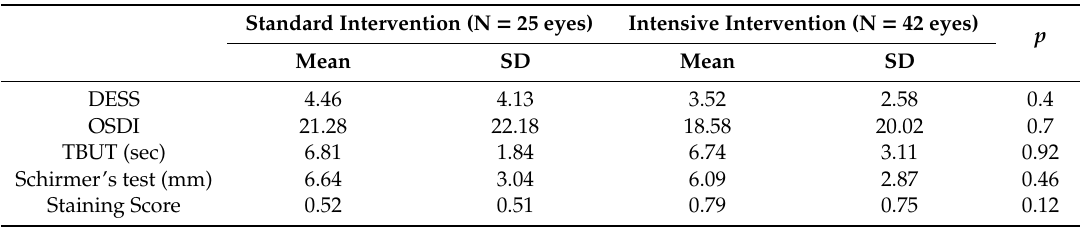
Table 3. Baseline clinical